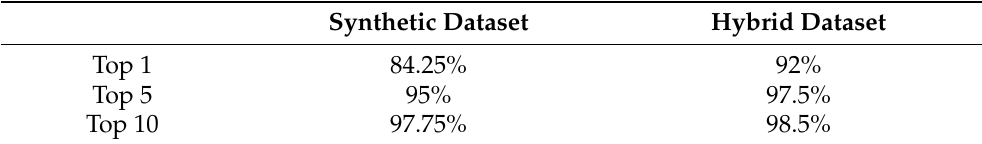
Table 4. Comparing the accuracy of character recognition using different training datasets.